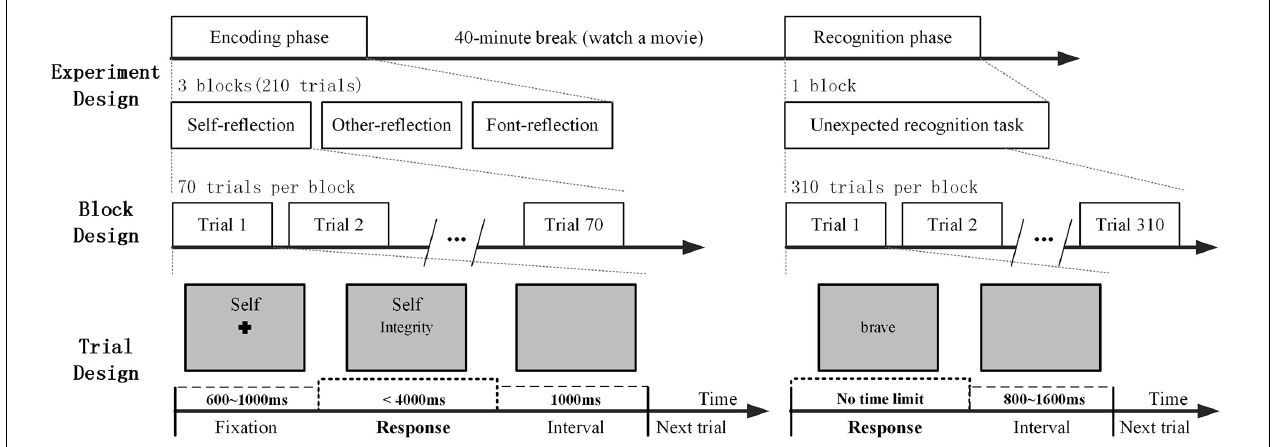
FIGURE 1 | A schematic diagram of experimental design: the encoding phase and the recognition